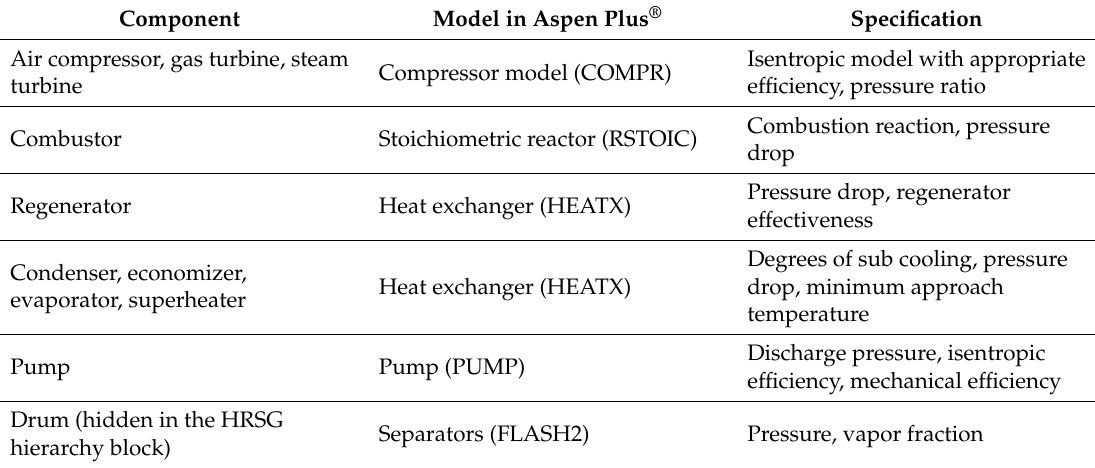
Table 2. Model description of analyzed power cycles in Aspen Plus ® .